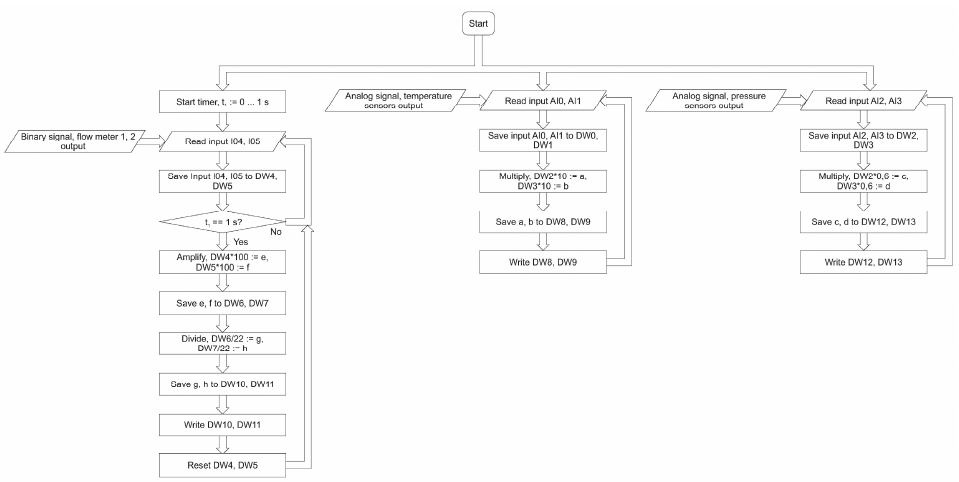
Figure 10. The flow meter algorithm.